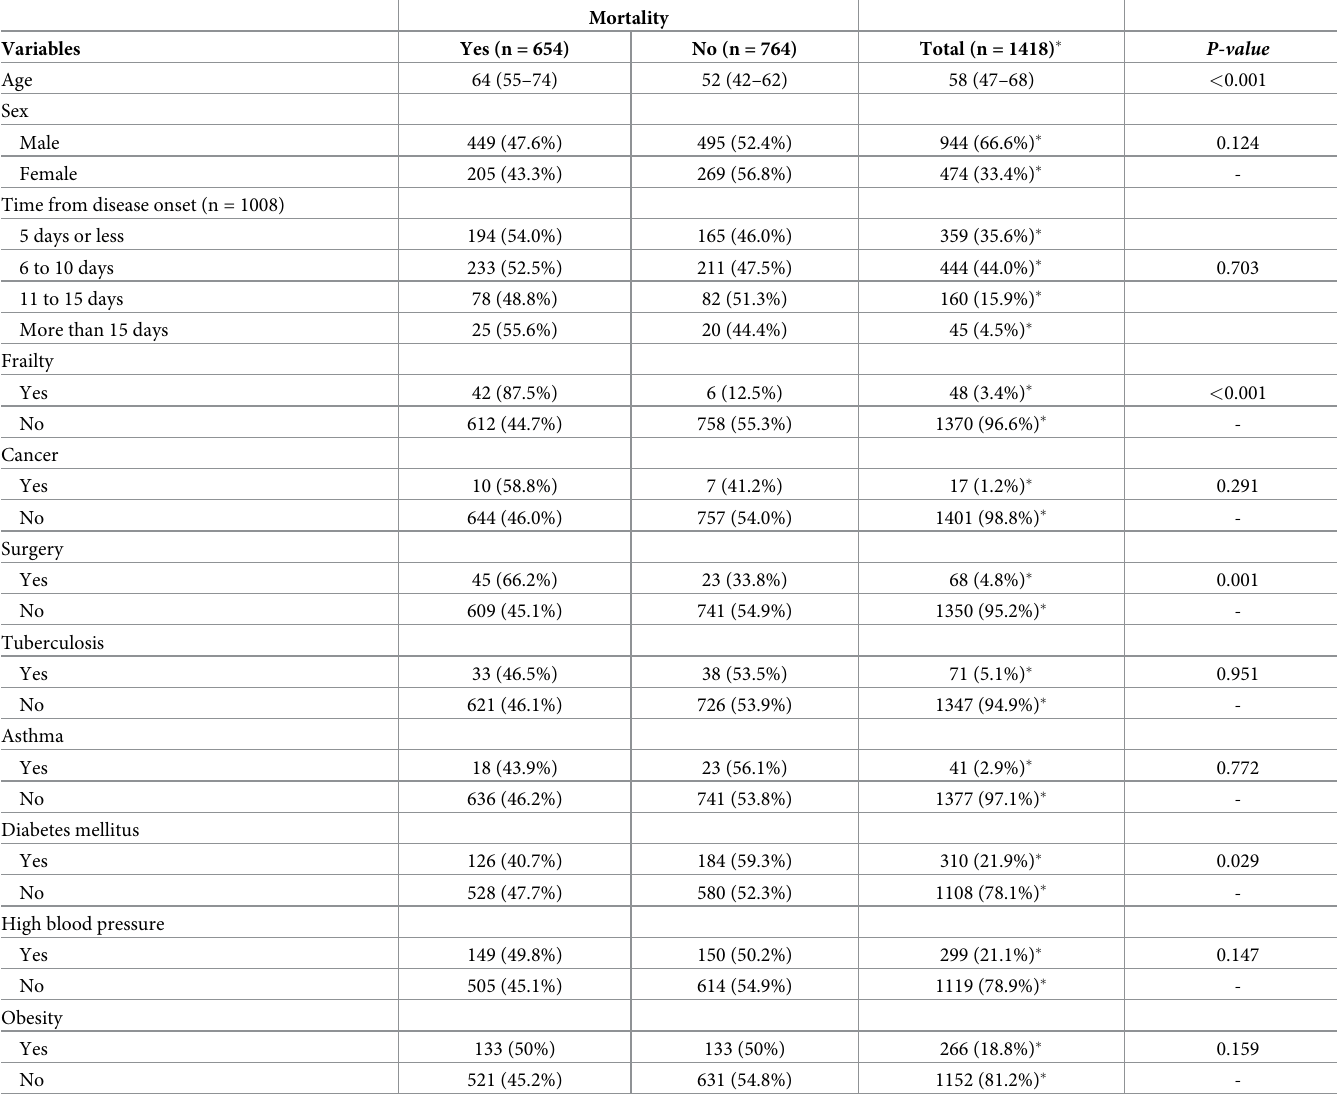
Table 1. Sociodemographic characteristics, history, and its association with mortality in patients with COVID-19 admitted to the Hipo´lito Unanue National Hospi- tal during April to August 2020. Lima, Peru.